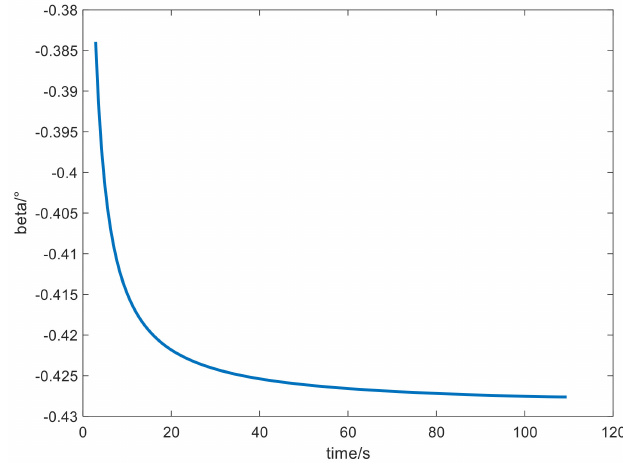
Figure 25. Calculated angle of sideslip results.